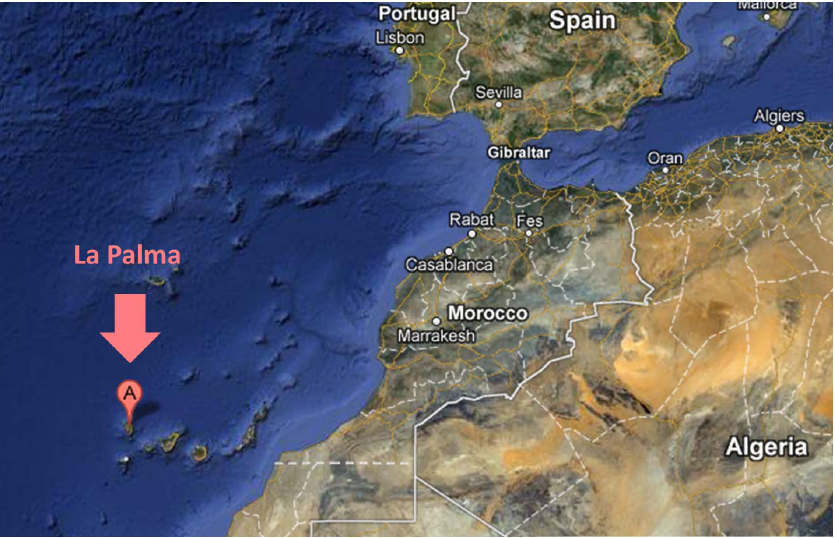
Figure 1. The La Palma Island, in the Canary Island